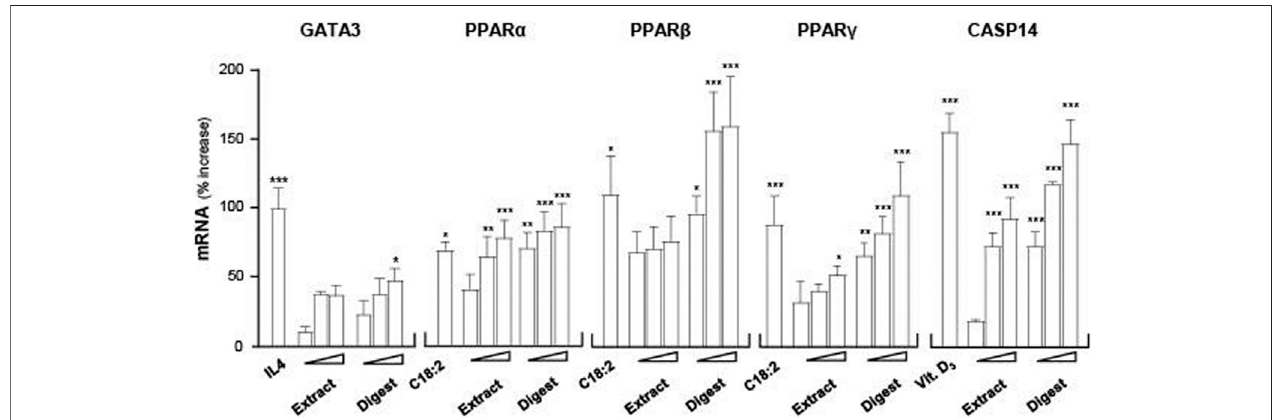
FIGURE 6 | EBN induces mRNA expressions of targeted genes corresponding to moisturize skin. The mRNA levels of GATA3, PPAR α , PPAR β , PPAR γ , and CASP14 in cultured differentiated keratinocytes after 24-h treatments of EBN extract and digest were determined in doses of 1, 10, 100 μ g/mL (as indicated). IL-4 at 100 ng/mL, linoleic acid (C18:2) at 30 μ M and cholecalciferol (vitamin D 3 ) at 10 – 5 M were adopted as positive controls in GATA3, PPARs, and CASP14 expressions. Values are expressed as the percentage of increase in mRNA amount relative to normalized basal expression set at 0 in mean ± SEM, n (cid:2) 4. Statistically signi fi cant results are marked with * p < 0.05, ** p < 0.01, and *** p < 0.001 against the